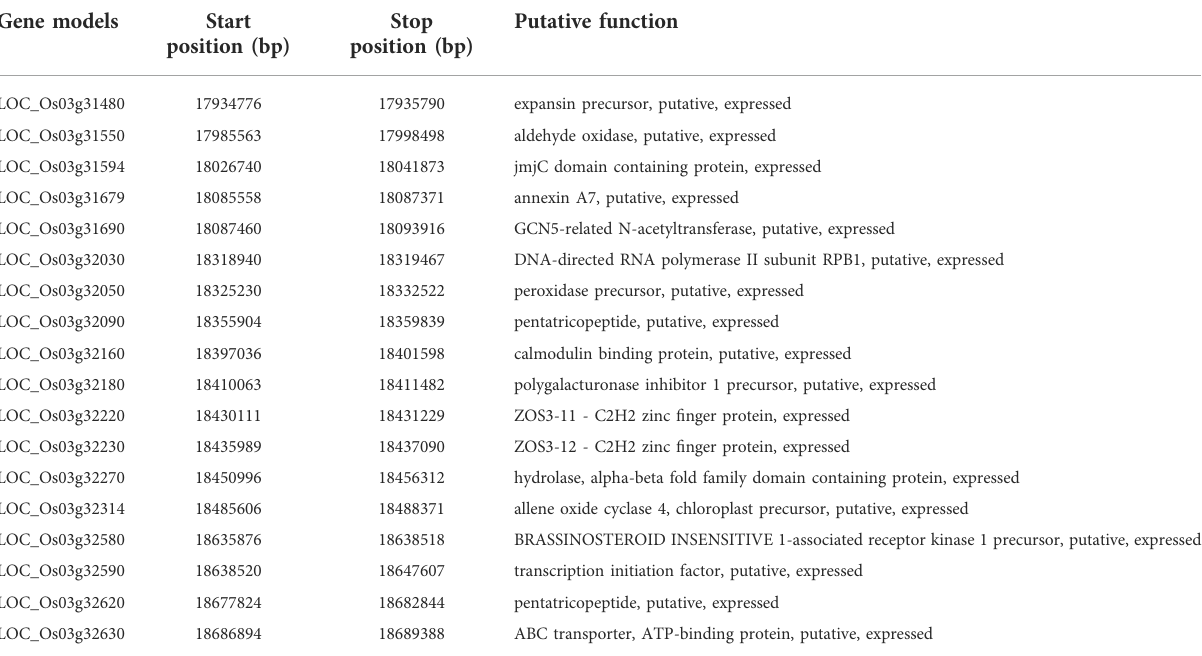
TABLE 4 The predicted gene models in the novel QTLs qCKL3.2/qMRL3.2 Gene